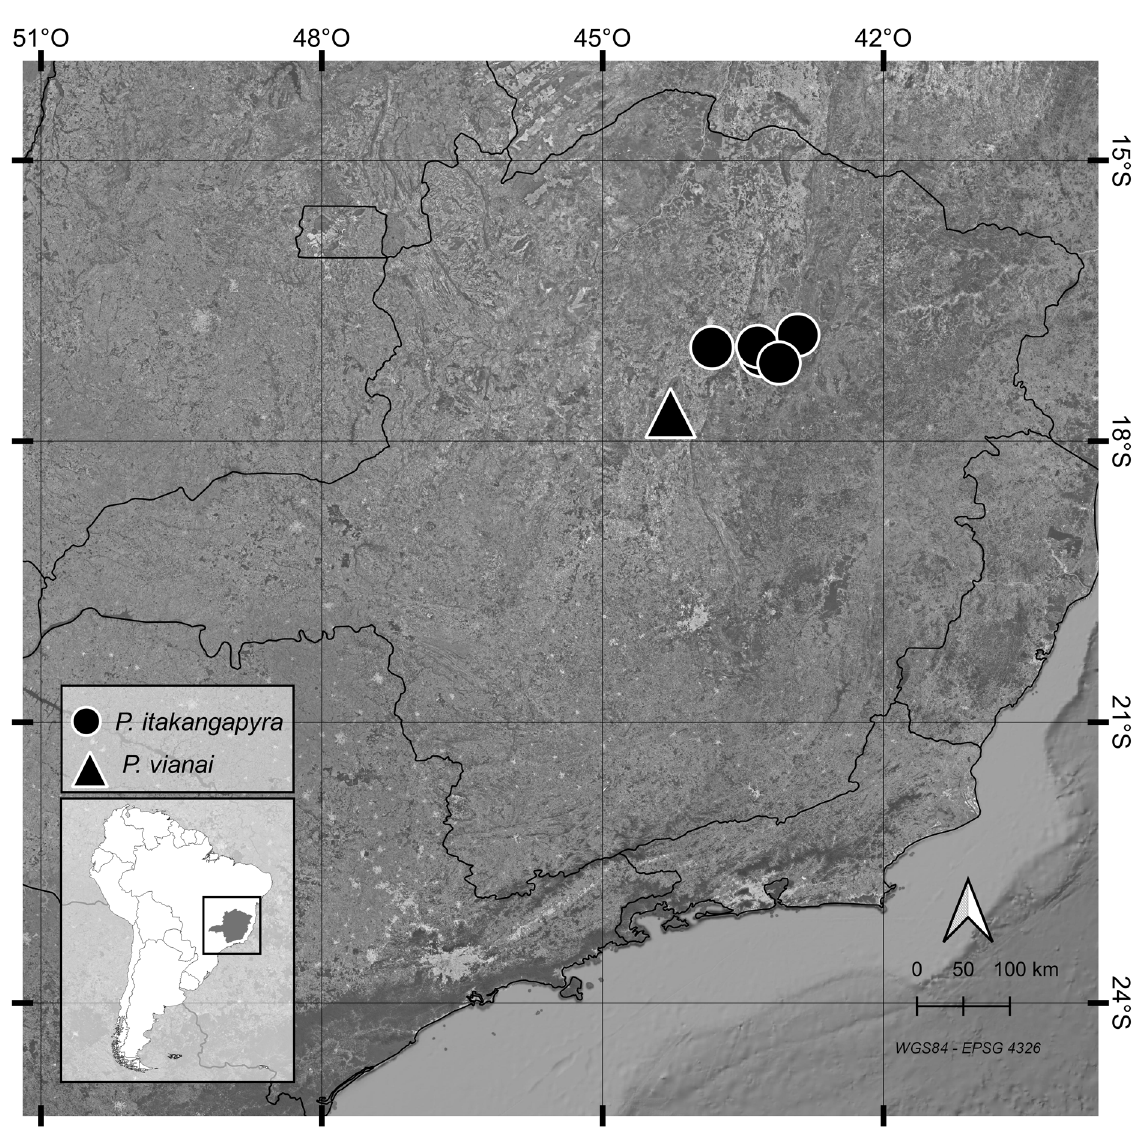
Fig. 7. Distribution map of Psyllocarpus itakangapyra Sobrado, J.A.M.Carmo & R.M.Salas sp. nov. and P. vianae Sobrado, J.A.M.Carmo & R.M.Salas sp. nov. in the state of Minas Gerais,